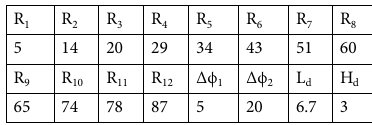
Table 1. Dimensions (millimeters).